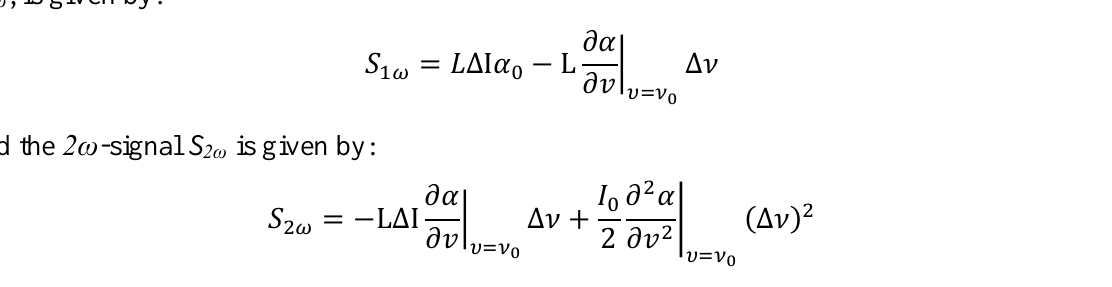
Figure 5. 1f-QEPAS (a) and 2f-QEPAS (b) spectral scans of 2.6 ‰ of CO pressure of 50 Torr of a CO strong background of the spectral 1f-QEPAS